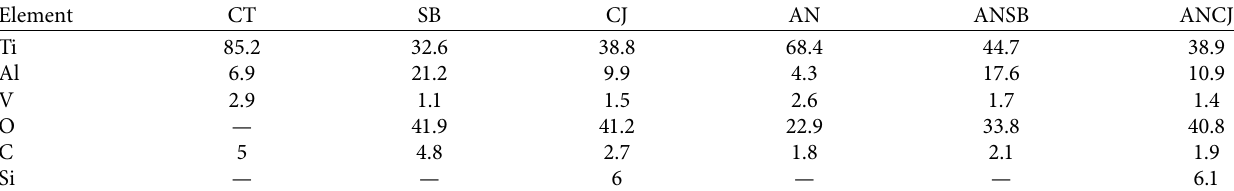
Figure 4: SEM images at 500x and 1000x magnification of the tested groups. Table 4: Elemental composition (%) from EDS analysis of tested groups.